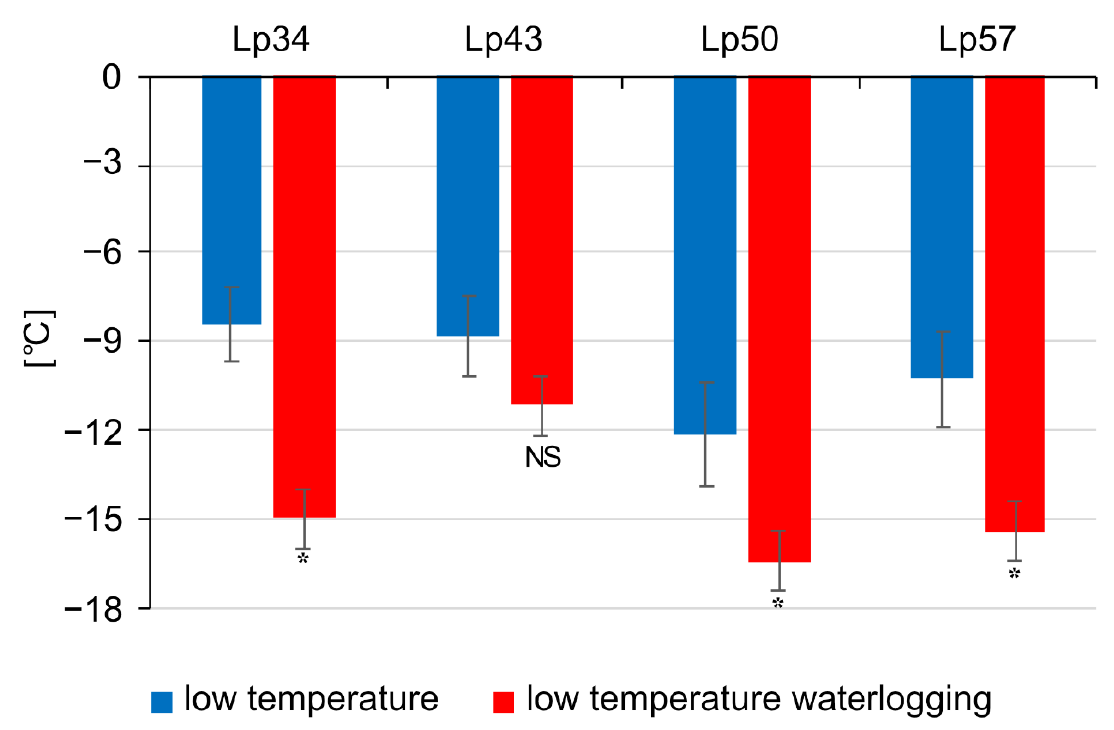
Figure 1. Frost tolerance expressed as the RT 50 value (the temperature at which a 50% decrease in regrowth is observed) in Lolium perenne genotypes cold-acclimated for 21 days. Four genotypes (Lp34, Lp43, Lp50, and Lp57) were tested. The results are means ( n = 6), error bars indicate the standard error. Asterisks indicate means that differed significantly between waterlogged and control plants ( p < 0.05).